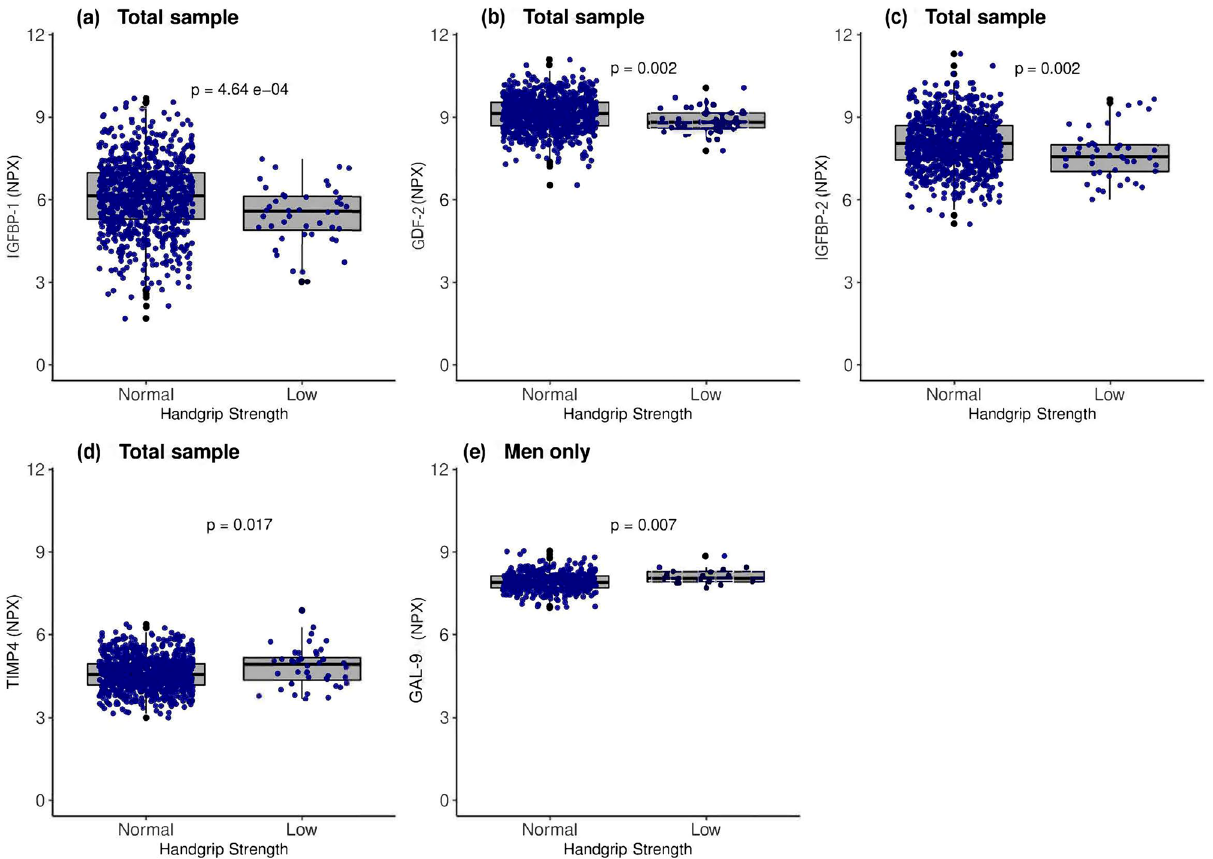
Figure 6. A comparison of selected biomarkers between participants with normal and low HGS. The Wilcoxon rank-sum test was used to compare groups. The box and whisker plots represent medians and interquartile ranges. NPX: Normalized protein expression; p: P value. Full names of all biomarkers are listed in Additional Table